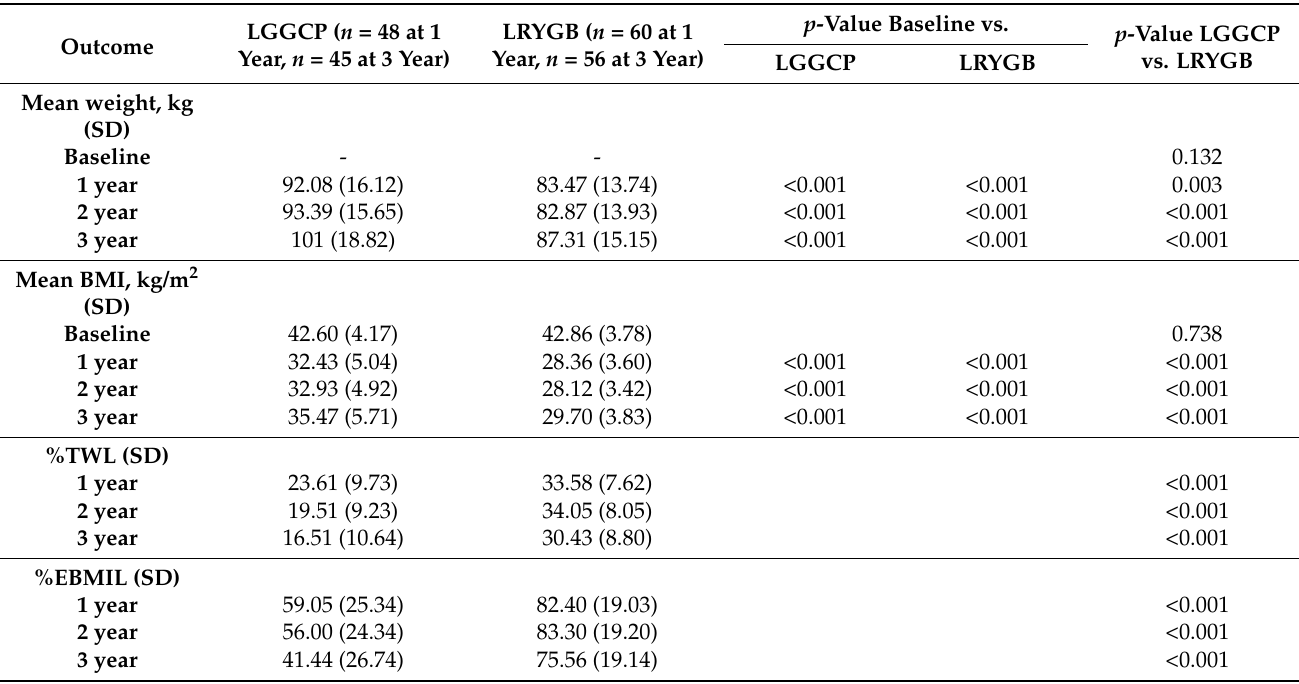
Table 2. Comparison of the weight and BMI 1 year, 2 year and 3 year after LRYGB and LGGCP.